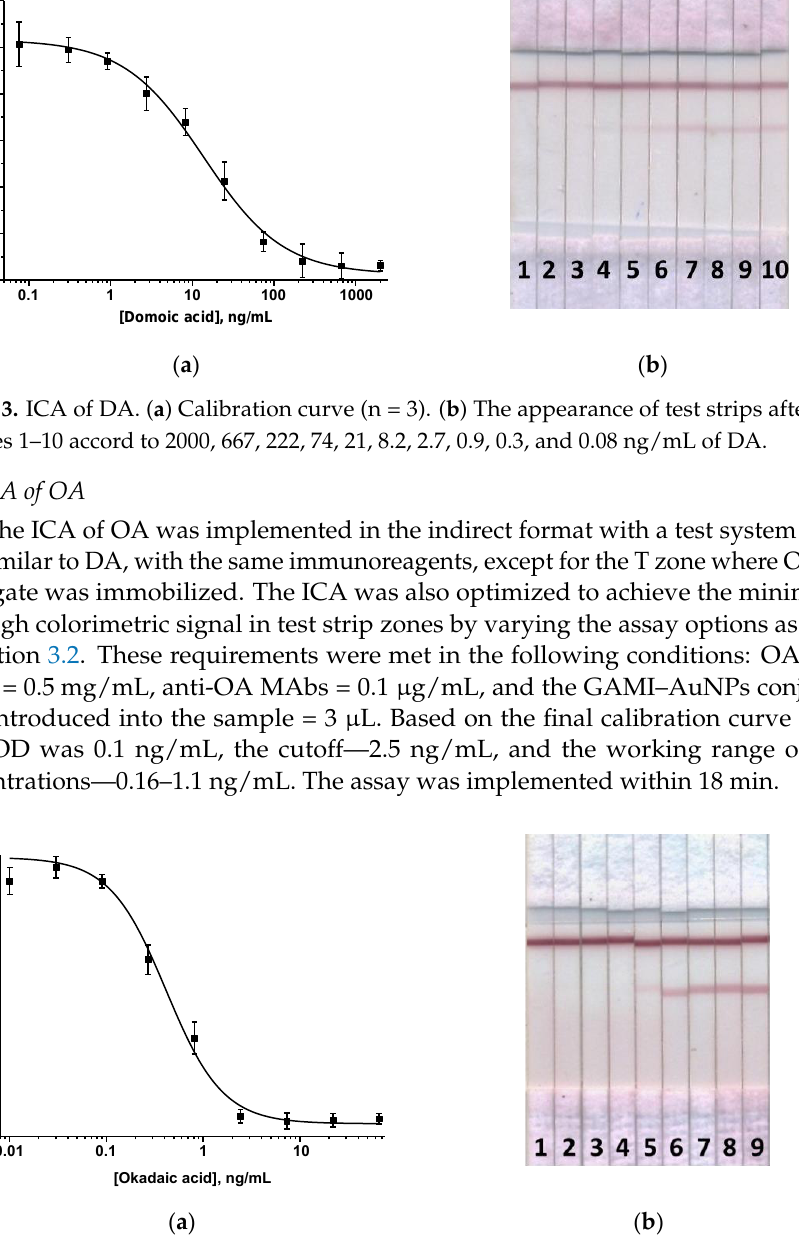
Figure 4. ICA of OA. ( a ) Calibration curve (n = 3). ( b ) The appearance of test strips after the assay. Samples 1 – 9 accord to 66, 22, 7.3, 2.4, 0.8, 0.3, 0.09, 0.03, and 0.01 ng/mL of OA.